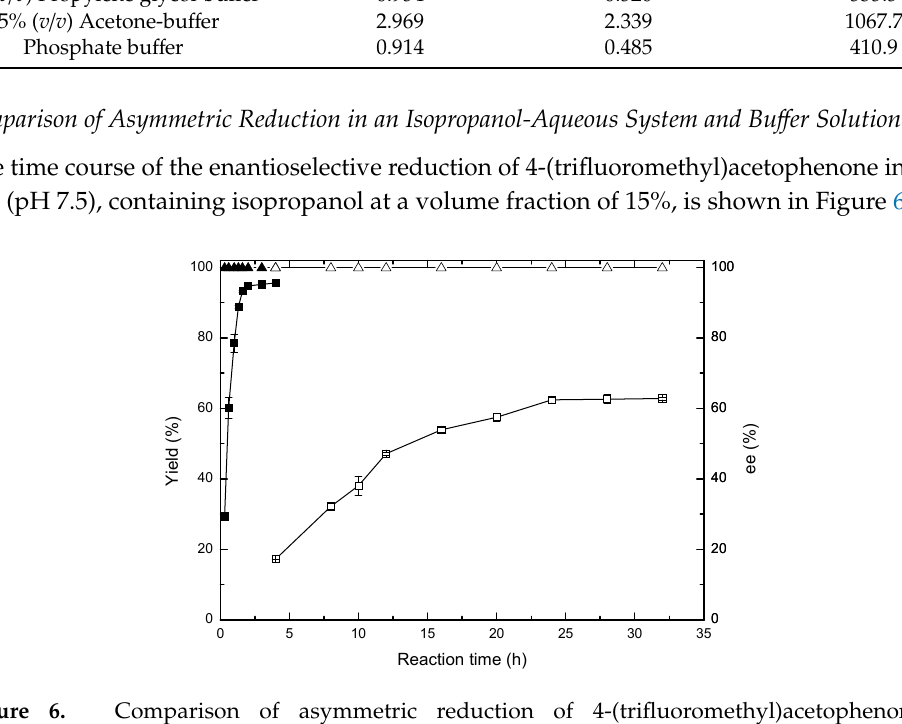
Figure 6. Comparison of asymmetric reduction of 4-(trifluoromethyl)acetophenone in isopropanol-buffer medium and aqueous system. Symbols: ( ■ ) Yield in 15% ( v / v ) isopropanol-buffer solution and ( □ ) yield in buffer solution, ( ▲ ) ee in 15% ( v / v ) isopropanol-buffer solution and ( △ ) ee in buffer solution.